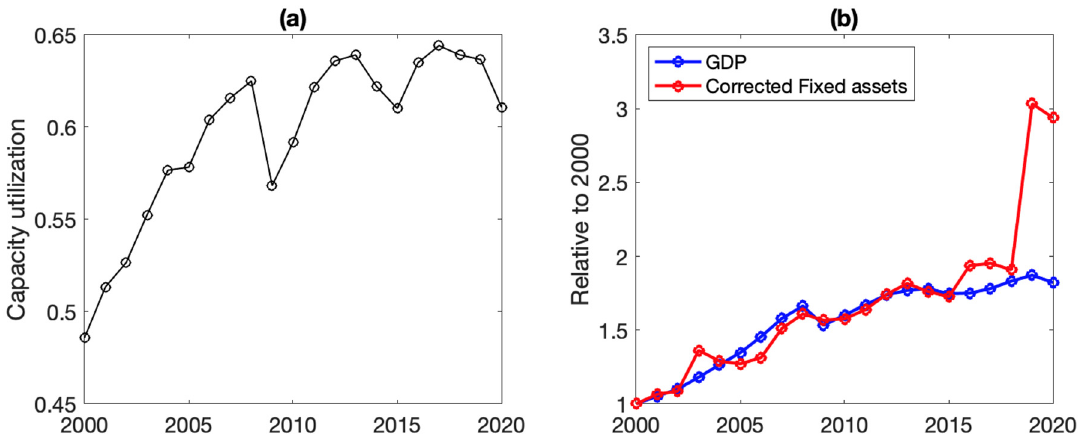
Figure 4. ( a )—Dynamics of capacity utilization (https://macrovar.com/russia/capacity-utilization/ (accessed on 21 January 2023)); ( b )—GDP and utilization-adjusted value of fixed assets (CVFA, Corrected Fixed assets).